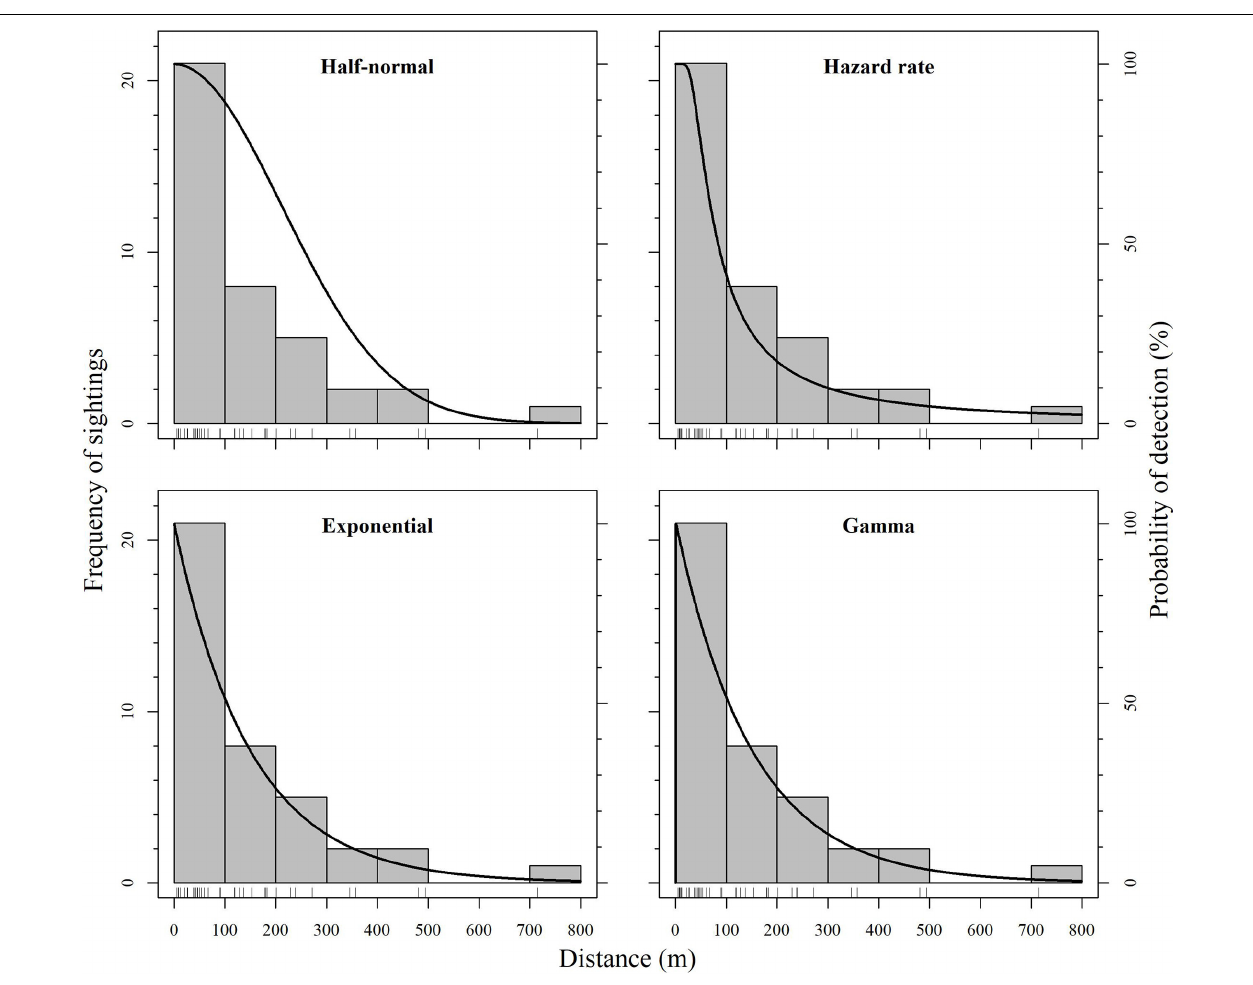
FIGURE 2 | Histogram of detection at increasing distance (gray bars, observed data are represented by the small bars on the x-axis) and fitted detection function (solid line) for the four density function models (half-normal, hazard rate, negative exponential, and gamma).